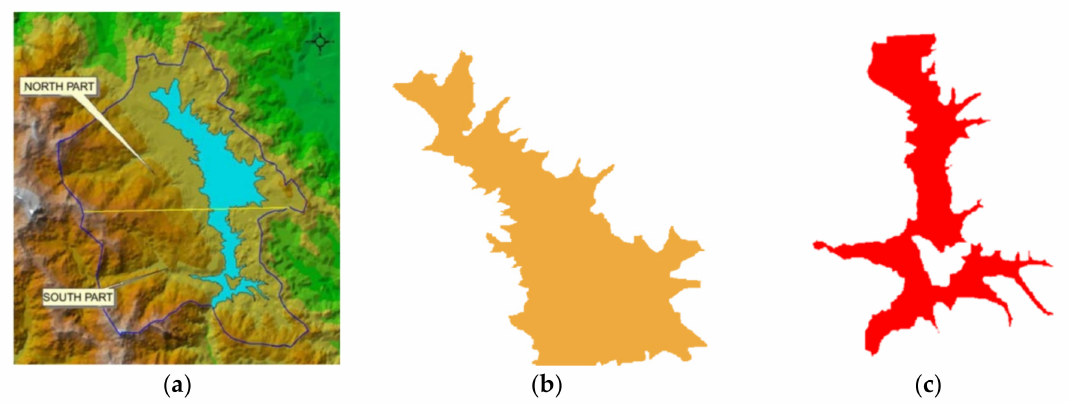
Figure 11. ( a ) Plastiras reservoir; ( b ) presence of water in the north part of the lake; ( c ) presence of water in the south part of the lake.